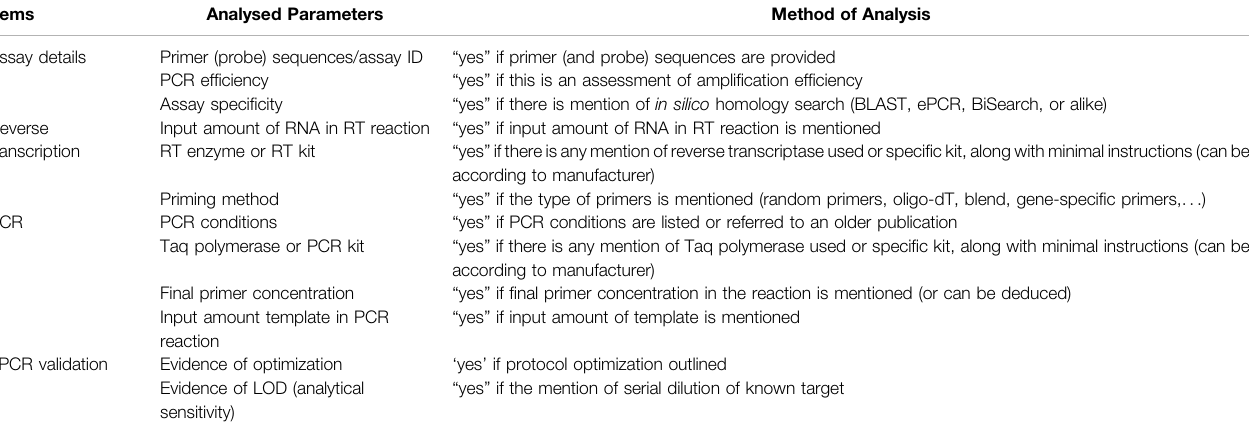
TABLE 2 | Quality and application with MIQE guidelines. Modi fi ed from Nour et al. (2014). Items Analysed